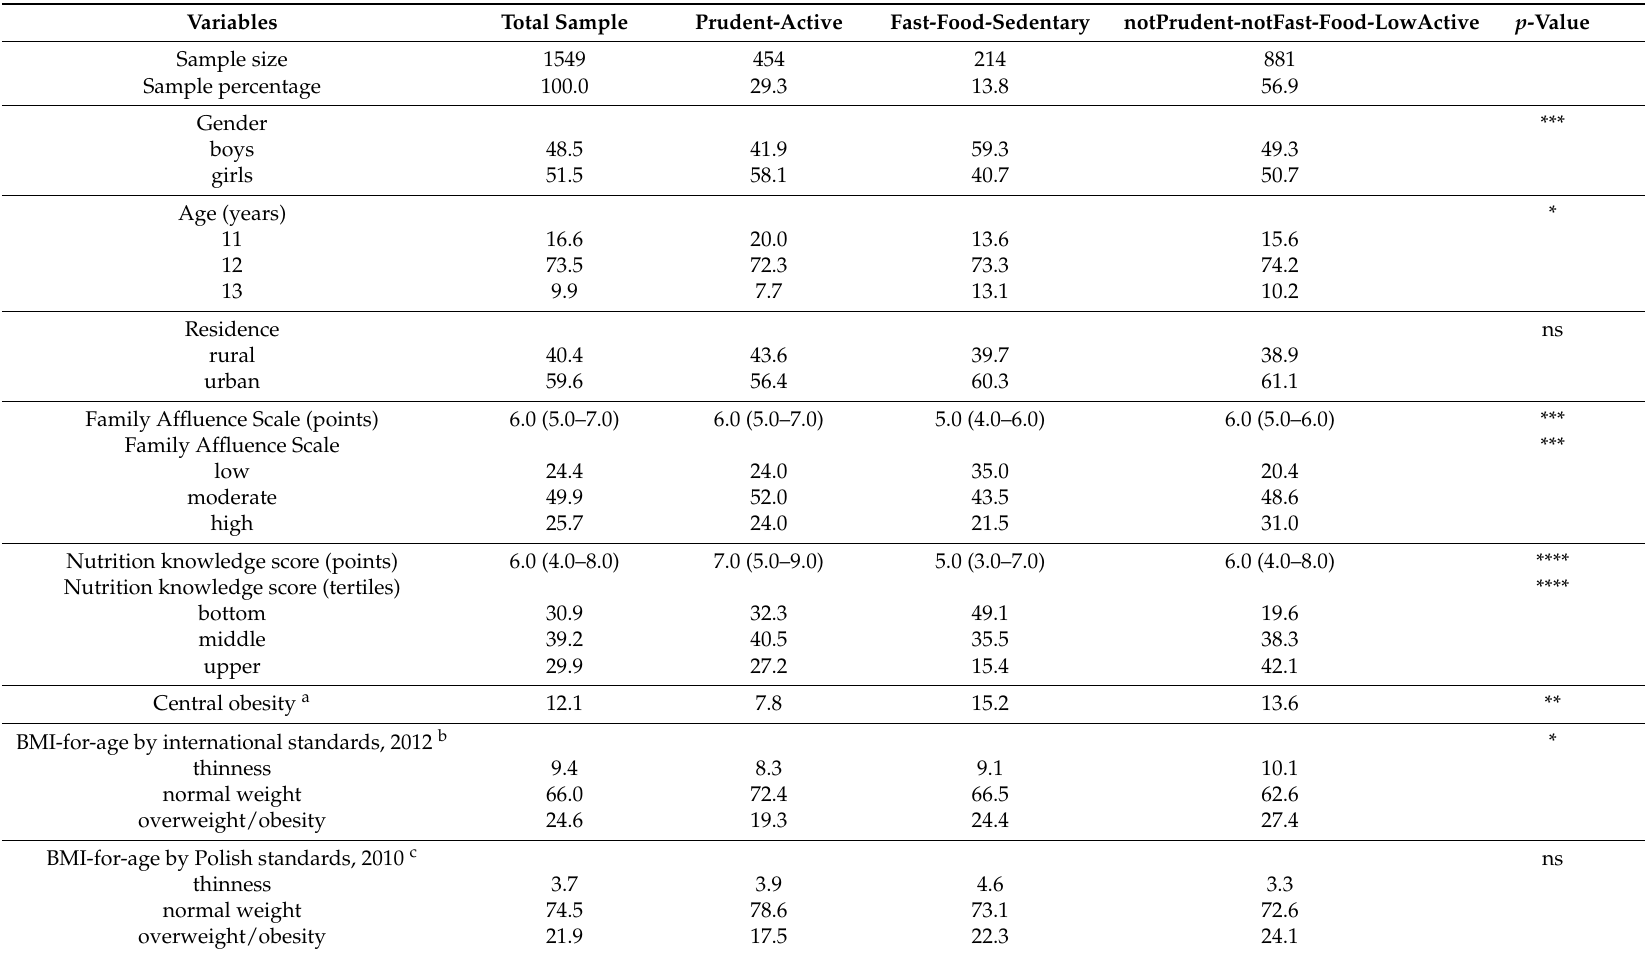
Table 1. Sample characteristics by dietary-lifestyle patterns (% of the sample or median (interquartile